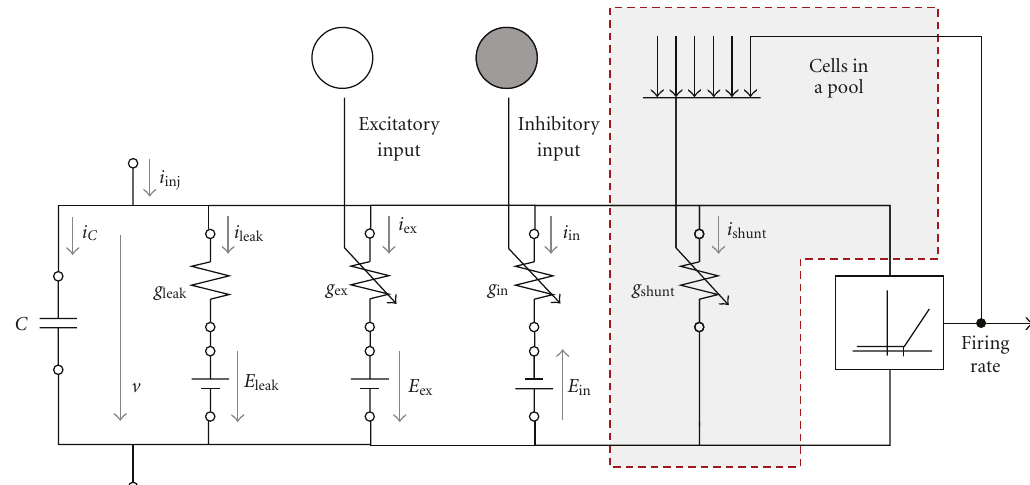
Figure 3: Circuit model to describe the dynamics of the membrane potential of a model cell. Simple single compartment models of neurons describe the membrane as a layered patch of phospholipid molecules that separate the internal and external conducting solution acting as an electrical capacitance. The membrane is an electrical device consisting of a capacitance, C , a specific membrane resistance, R , and a resting potential driven by a battery ( E leak ). The model takes into account excitatory and inhibitory synaptic input currents to adaptively change the membrane conductance denoted by g ex and g in , respectively. The regulation of the membrane conductance by silent, or shunting, inhibition, g shunt , through the activity from a pool of cells is depicted by the component on the right (grey shaded region). See text for further details and